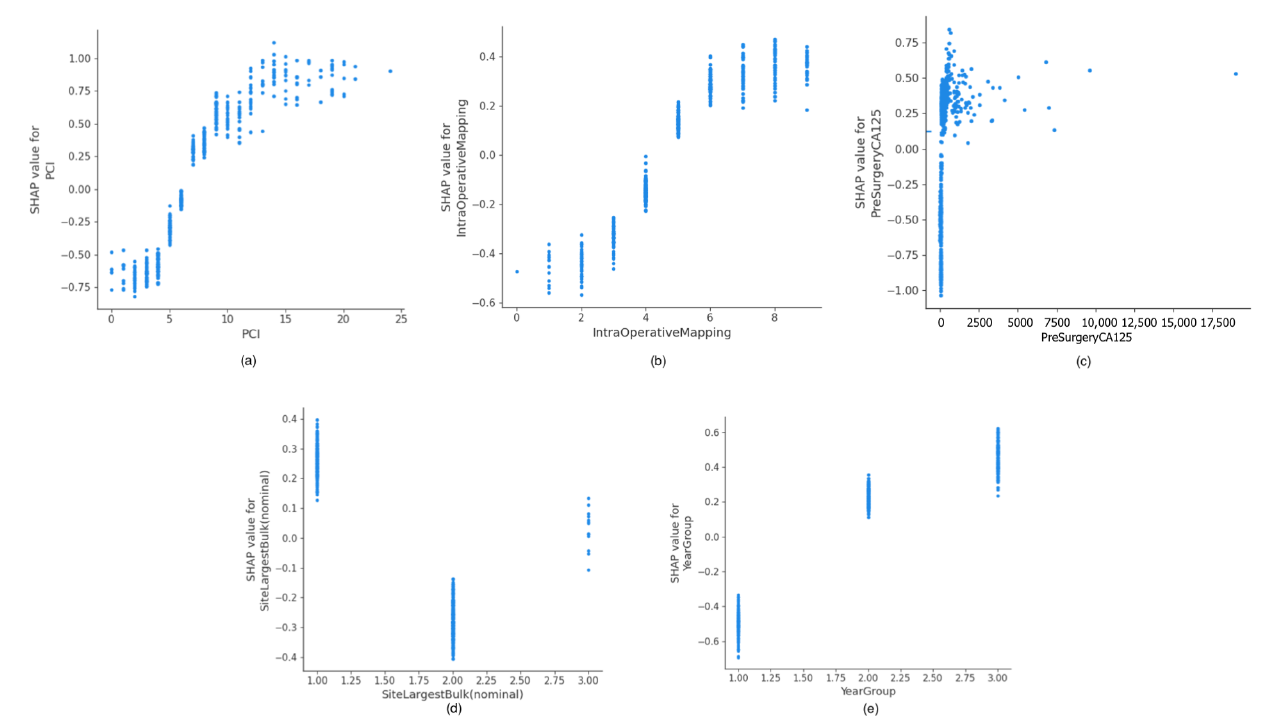
Figure 3. Examples of SHAP Value Dependence plots for top global explainability features showing the impact of each feature value on the prediction: ( a ) PCI, ( b ) Intra-Operative Mapping, ( c ) Pre- Surgery CA125, ( d ) Size of Largest Tumor, ( e ) Year of Surgery. PCI, Peritoneal Carcinomatosis